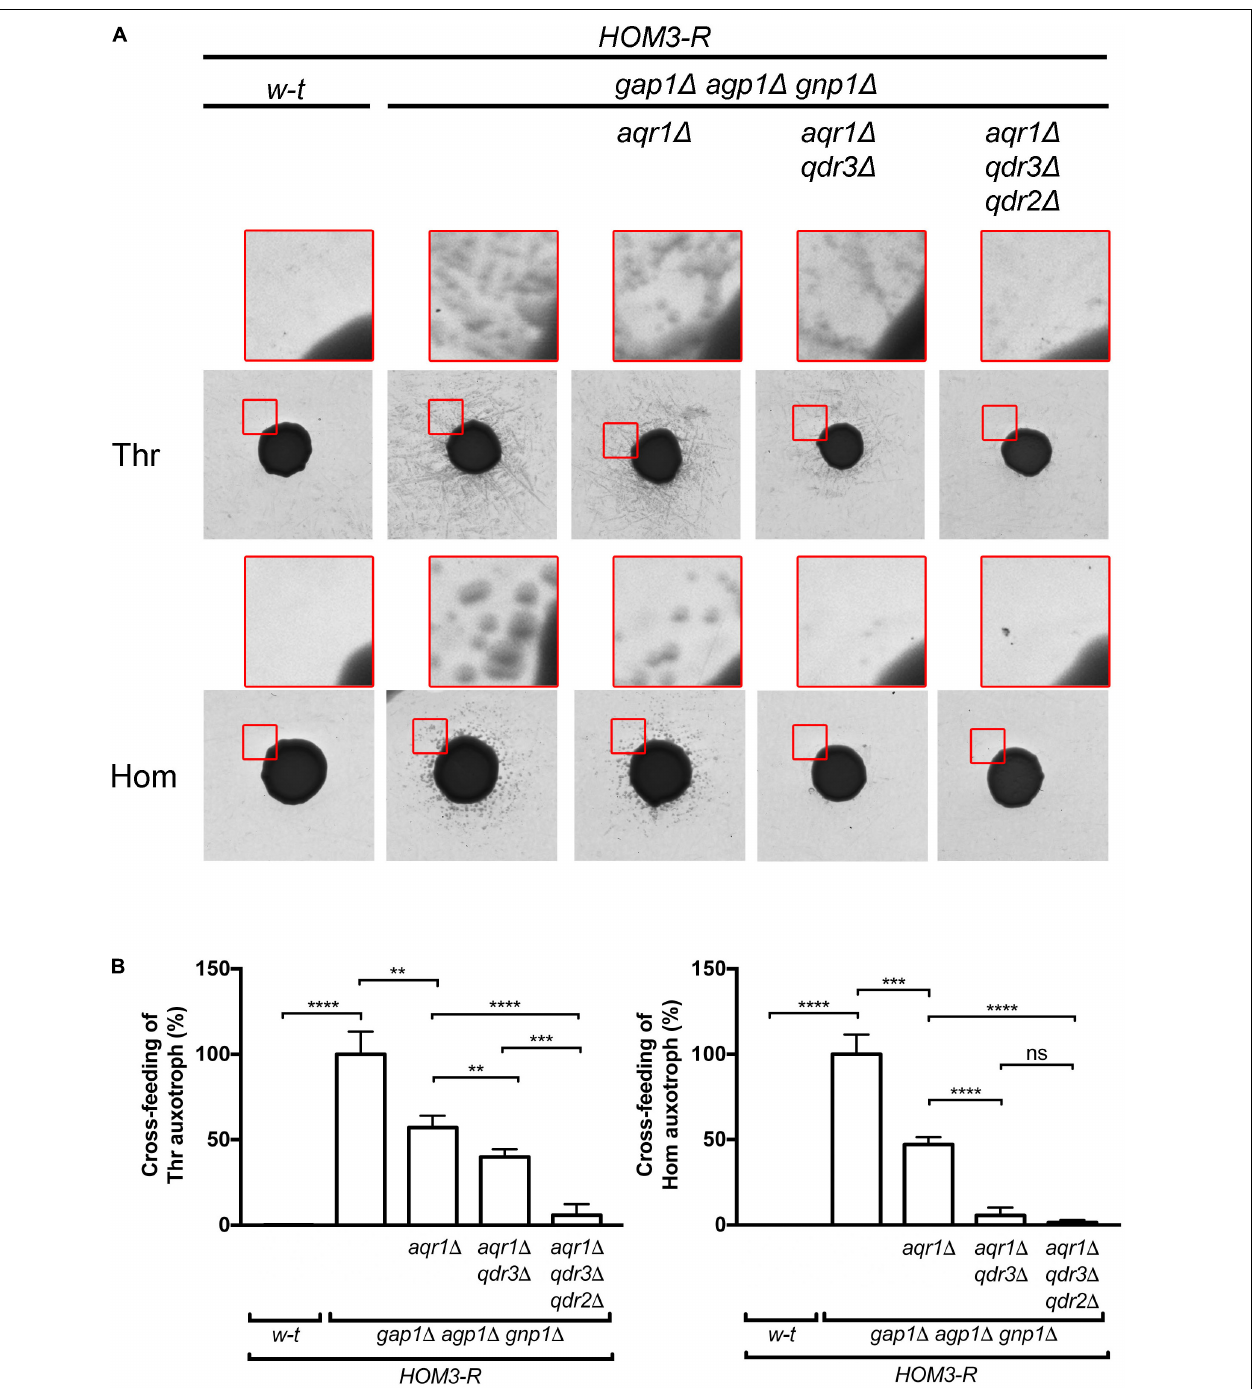
FIGURE 2 | Aqr1, Qdr2, and Qdr3 contribute to threonine and homoserine excretion. (A) Cross-feeding on solid medium of threonine (Thr) and homoserine (Hom) yeast auxotrophic mutants surrounding large colonies of the wild-type ( w-t ) or a mutant strain (genotypes indicated). All donor strains expressed HOM3-R from a plasmid (pGK008). Cells were grown in a minimal glucose medium with glutamate as sole nitrogen source. The presented images correspond to the inverted grayscale of original scans obtained for a representative experiment (original images are available in Supplementary Figure 1 ). Upper images in red squares correspond to enlargements of a zone at the periphery of the central donor colony. (B) Cross-feeding results as illustrated in A were quantified by image digitization, measurement of the pixel values corresponding to satellite colonies of the auxotrophic strains, and normalization vs. the strain with functional AQR1 , QDR2 , and QDR3 genes. Bars represent averages of four independent experiments ± standard deviation. * indicates a statistically significant difference as determined with the unpaired t- test. ** P < 0.0021; *** P < 0.0002; and **** P < 0.0001. ns, not significant, P > 0.05.